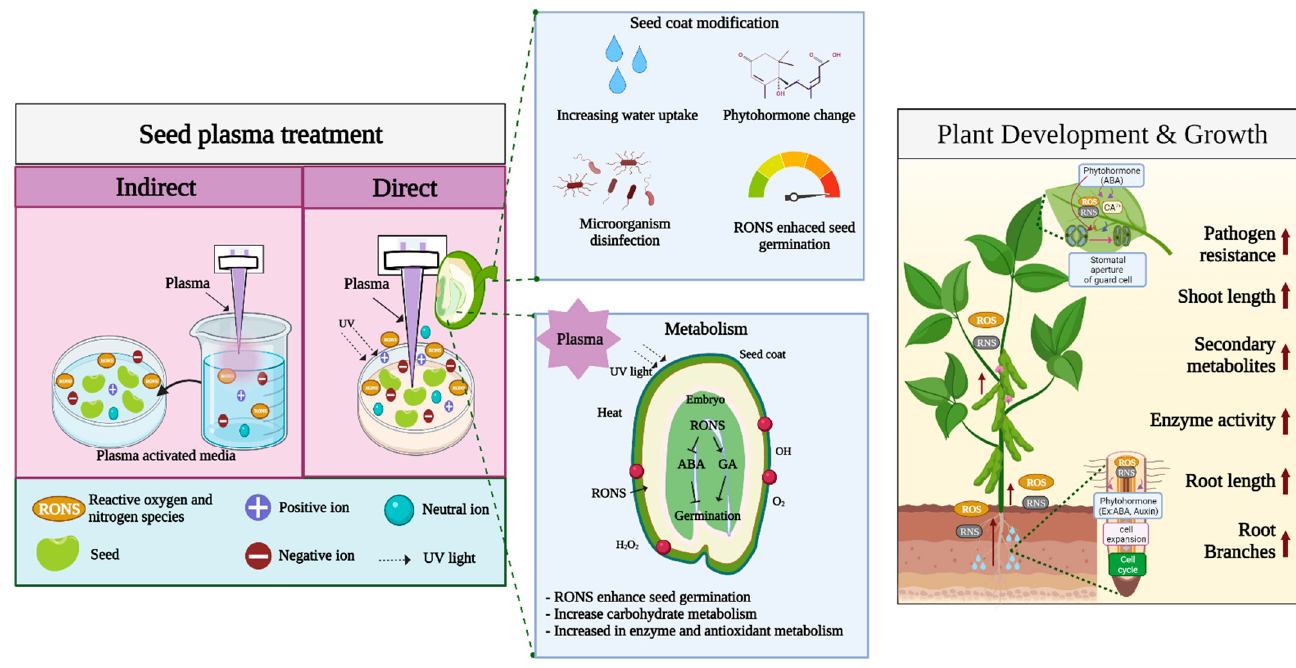
Figure 2. Overview of plasma treatment effects on seed germination and plant growth.